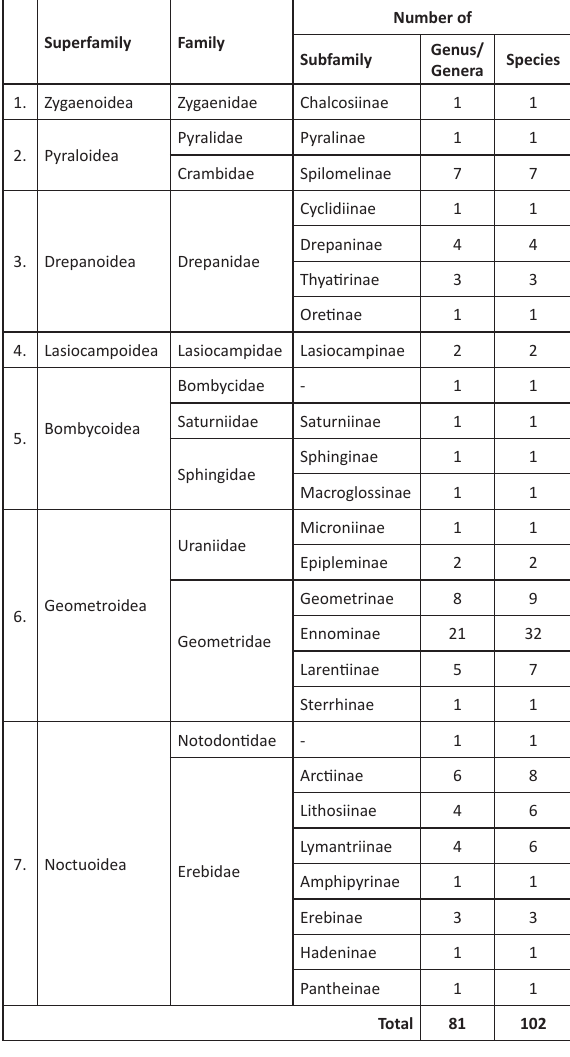
Table 1. Geographic coordinates of collection localities in Tawang District Collection localities